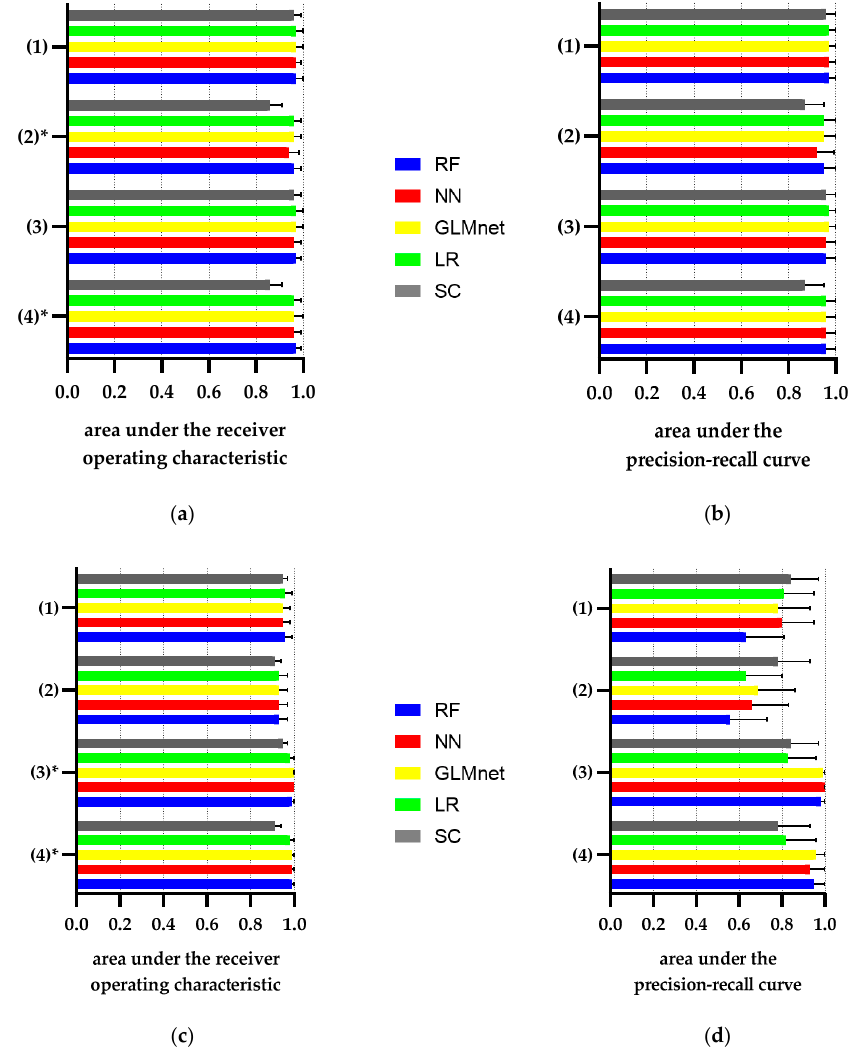
Figure 4. AUROC ( a , c ) and AUCPR ( b , d ) of the simple categorical classifier and of models calculated from logistic regression and the three ML methods for identification of CKD ( a , b ) and NKD ( c , d ) in different scenarios of data availability. ( a ) AUROC and ( b ) AUCPR for identification of CKD ≥ III; ( c ) AUROC and (d) AUCPR for identification of NKD. SC = simple categorical classifier, LR = logistic regression, GLMnet = generalized linear machine network, RF = random forest, NN = Artificial Neuronal Network. N = 156 patients (test dataset). Scenarios: (1) All data from the index hospital stay including laboratory values, demographics, ICD-billing codes and ICDs from discharge summaries; (2) laboratory values and demographics from the index hospital stay; (3) and (4) includes, in addition to (1) or (2), laboratory values from previous hospital stays, respectively. * Indicates p < 0.05 for di ff erence in AUROC between SC and all other